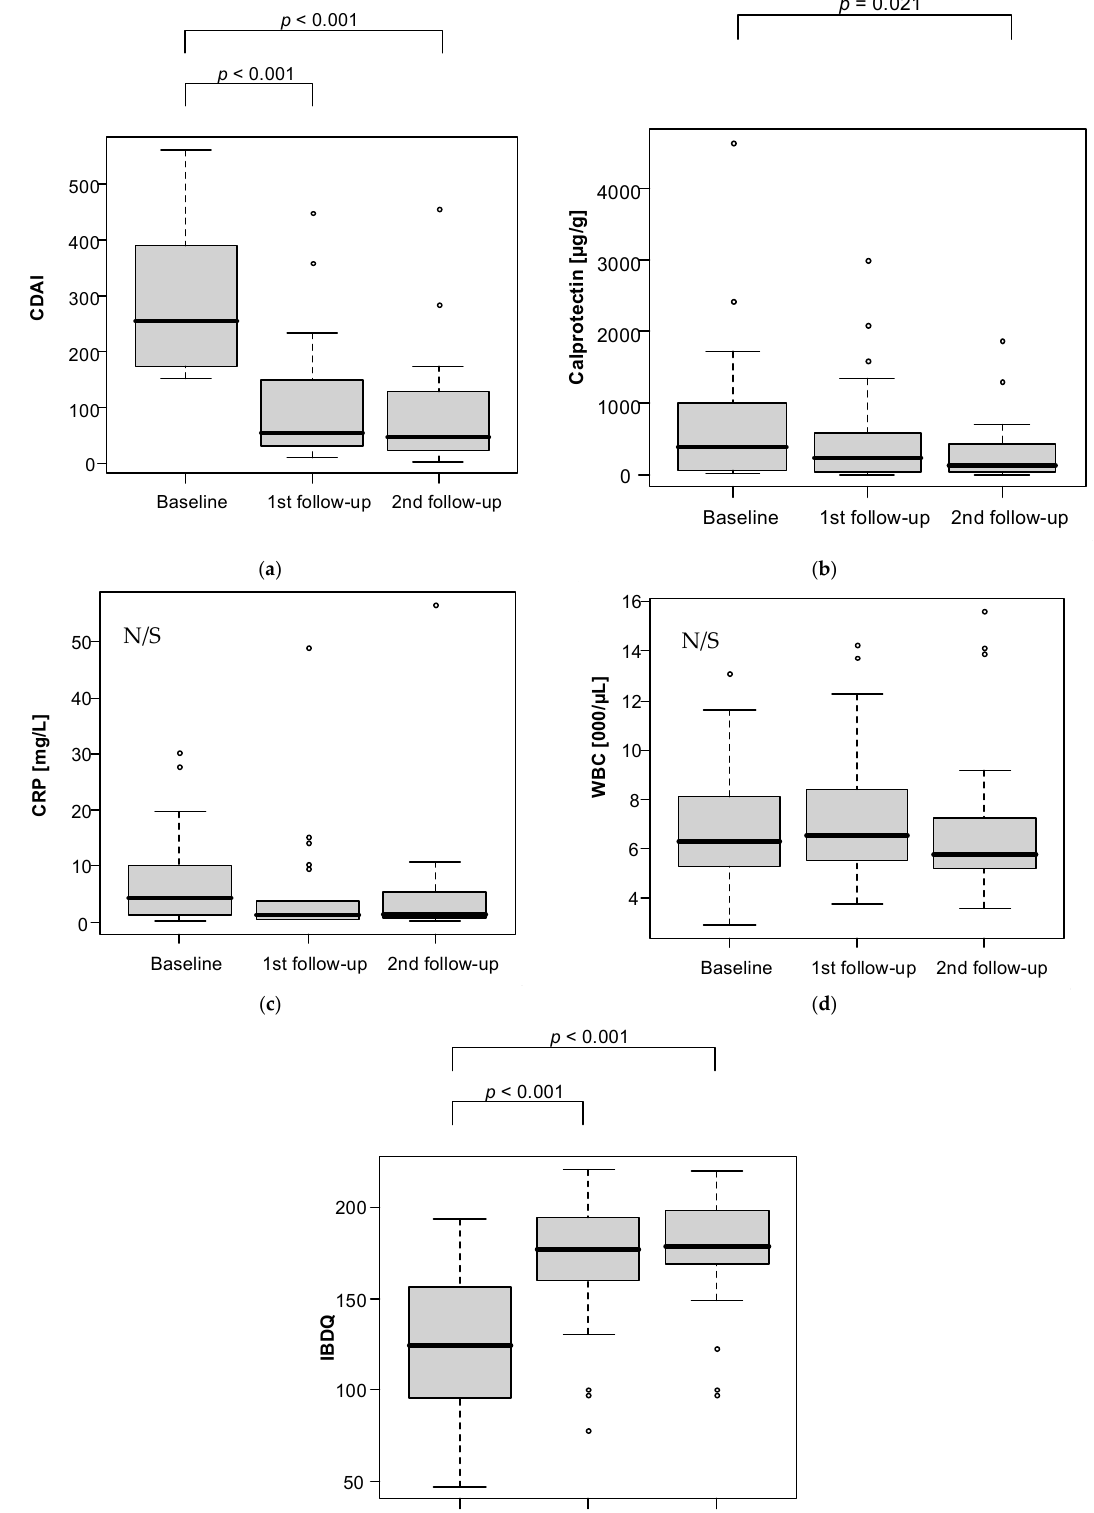
Figure 3. Analysis of changes in follow-up measurements regarding: ( a ) CDAI level; ( b ) calprotectin level; ( c ) CRP level; ( d ) WBC level; ( e ) IBDQ level.